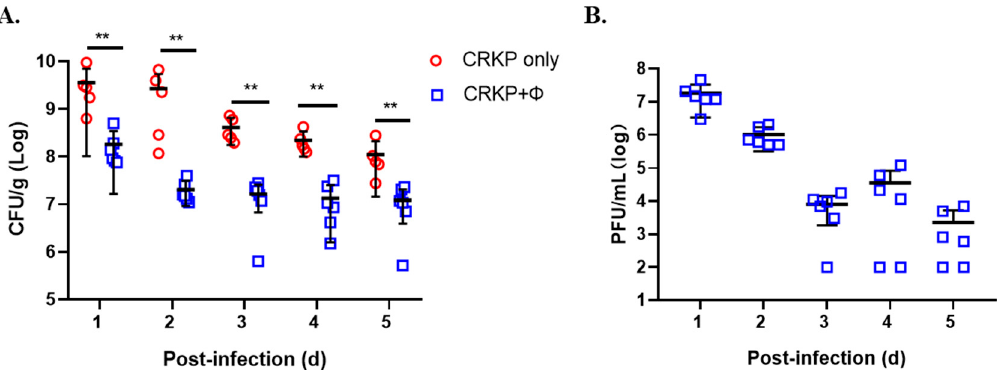
Figure 6. The effect of phage SRD2021 treatment in mouse intestine colonization. ( A ) CRKP CFU. ( B ) Phage titers. Approximately 10 8 CFU CRKP cells were intragastrically administered. SM buffer or SM buffer containing 10 8 PFU of phages was administered at 12 h post-infection. Fecal pellets were collected each day and CRKP numbers and phage titers were determined. Horizontal lines represent the average CFU level of CRKP colonized from six mice. ** p < 0.01 (Mann-Whitney test).